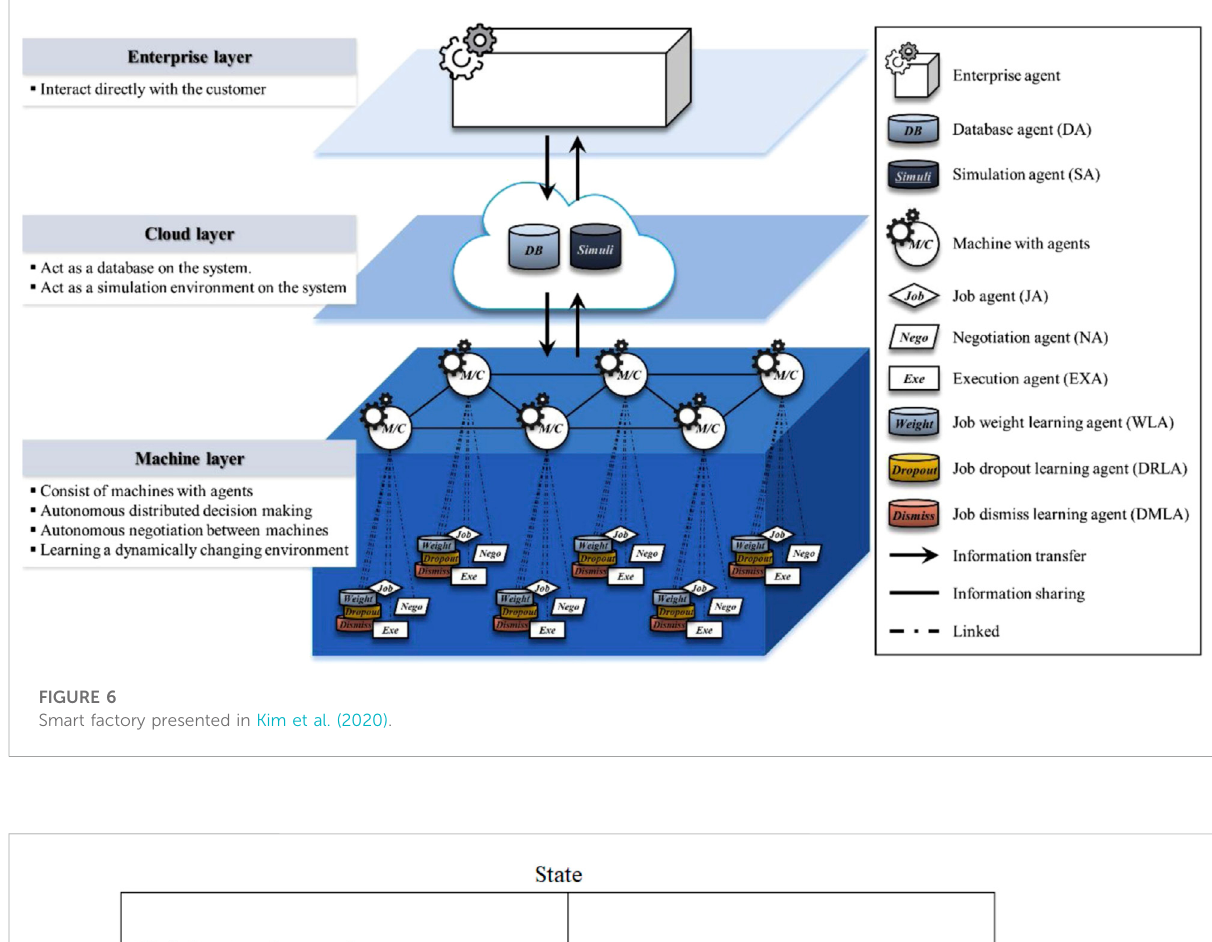
FIGURE 6 Smart factory presented in Kim et al. (2020).